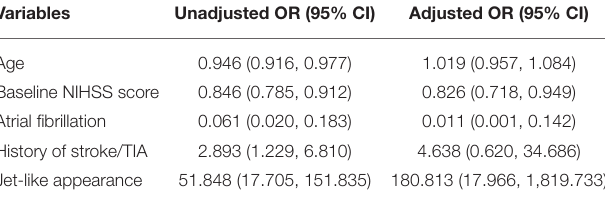
TABLE 3 | Univariant and multivariant logistic regression of predictors for